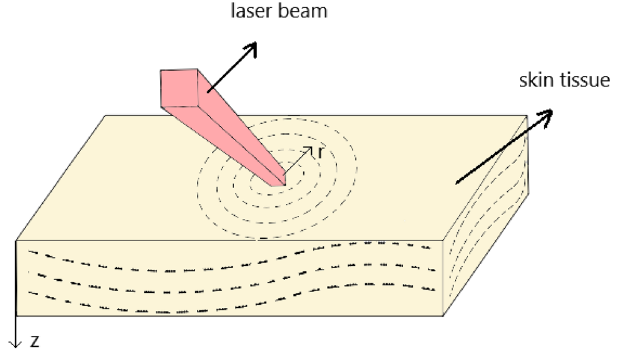
Figure 1. Thermoelastic vibration of the skin tissue in the presence of laser